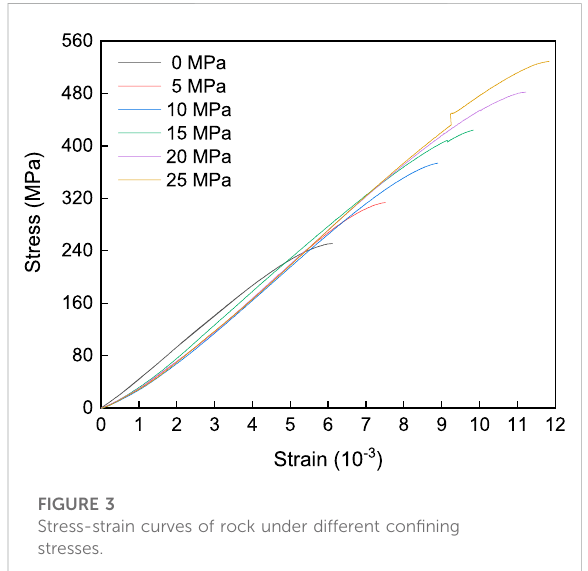
FIGURE 3 Stress-strain curves of rock under different con fi ning stresses.